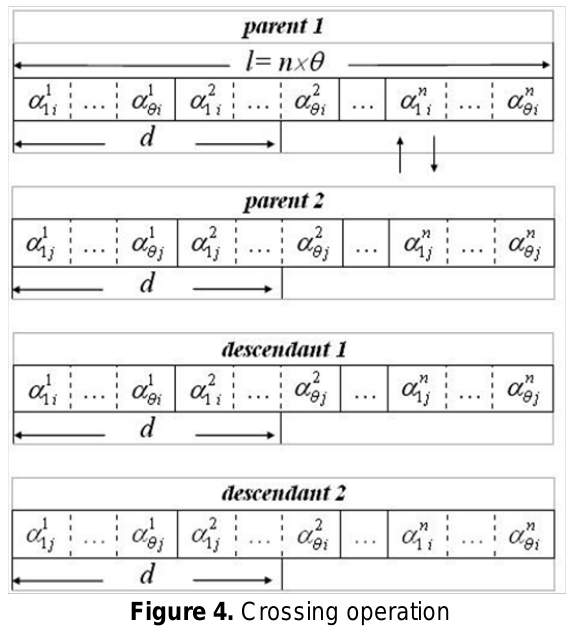
Figure 4. Crossing operation The rows i and j ( , 1 , ij